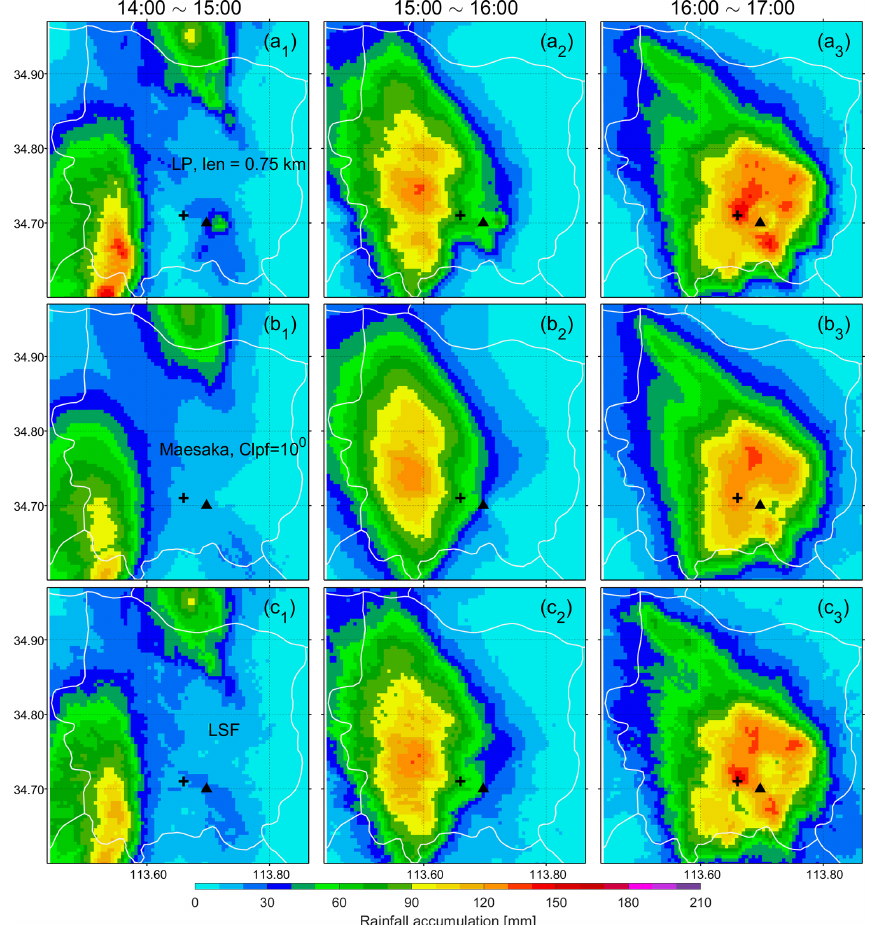
Figure 8. Hourly areal rainfall map from 14:00 to 17:00LST. K DP was estimated using (a) the LP method with LP = 0 . 75km, (b) the Maesaka method with Clpf = 10 0 , and (c) the LSF method. The black triangle and cross denote the Zhengzhou radar and the site hosting the gauge with the 201.9mmh − 1 report, respectively. R = 51 K 0 . 86 was used. DP